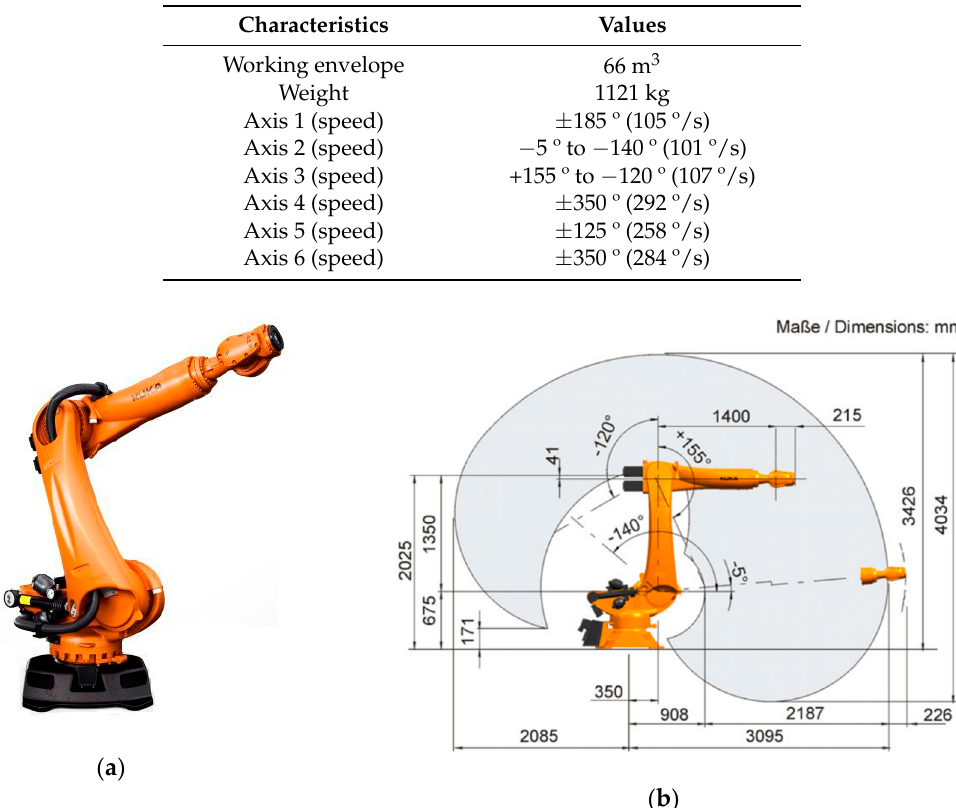
Figure 10. KUKA KR90 R3100 robot: ( a ) General aspect of the robotic arm manipulator; ( b ) Working envelope with dimensions comprised during operation. Images obtained from [23].